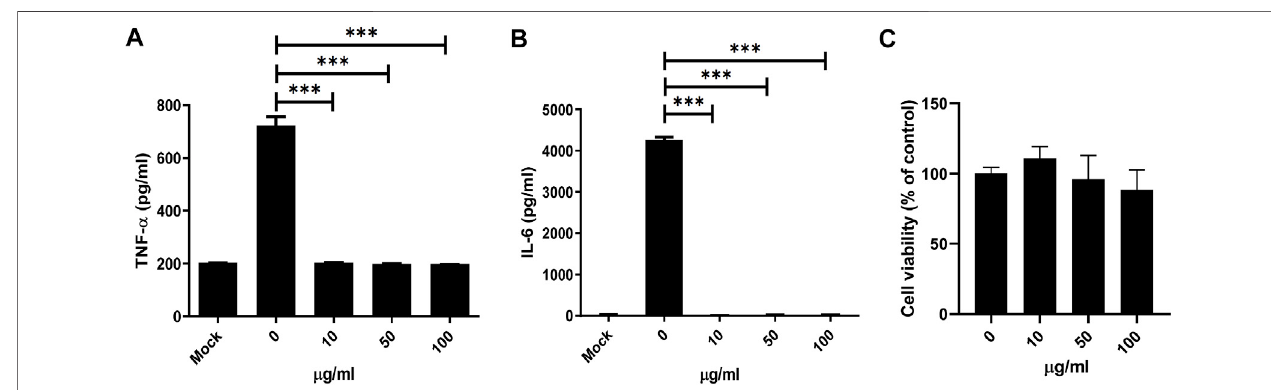
FIGURE 5 | MDP5 inhibited NF- κ B downstream cytokine production in BMDMs. BMDMs were pretreated with MDP5 (10 – 100 ug/ml) for 6 h then stimulated with Pam3CSK4 for cytokine production. Mock was shown by using BMDMs without Pam3CSK4. IL-6 (A) and TNF- α (B) production and viability (C) of BMDMs was measured after 12 h of Pam3CSK4-induced stimulation. Data are the mean ± S.D. ( n (cid:1) 5). ** p < 0.01, *** p < 0.001. Data were analyzed using the Student ’ s t -test (two- tailed).